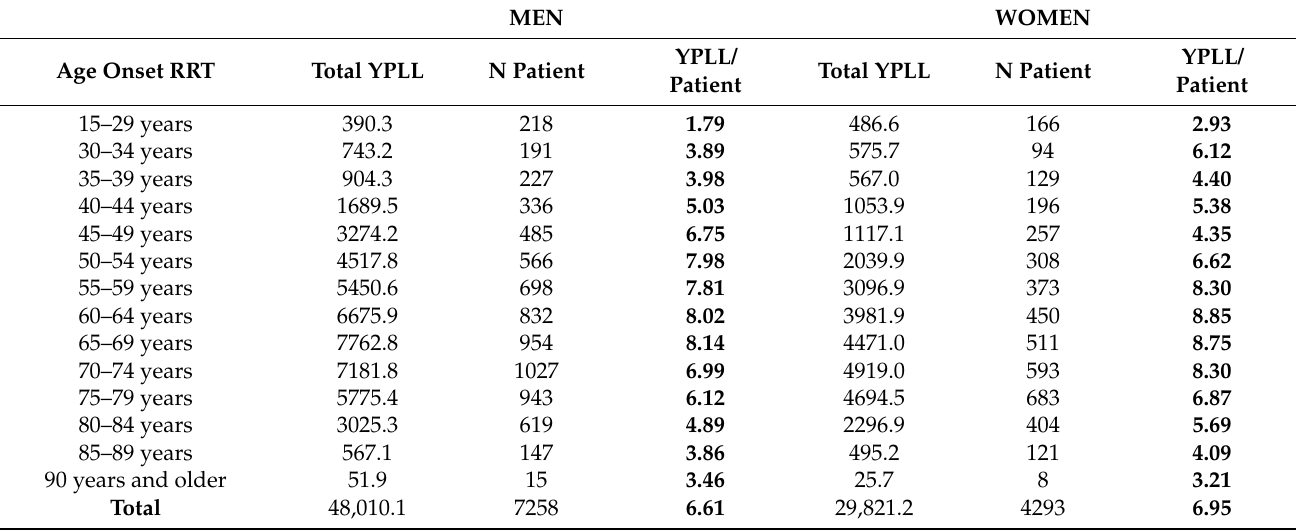
Table 2. Years of potential life lost (YPLL) in men and women according to age of onset of renal replacement therapy.